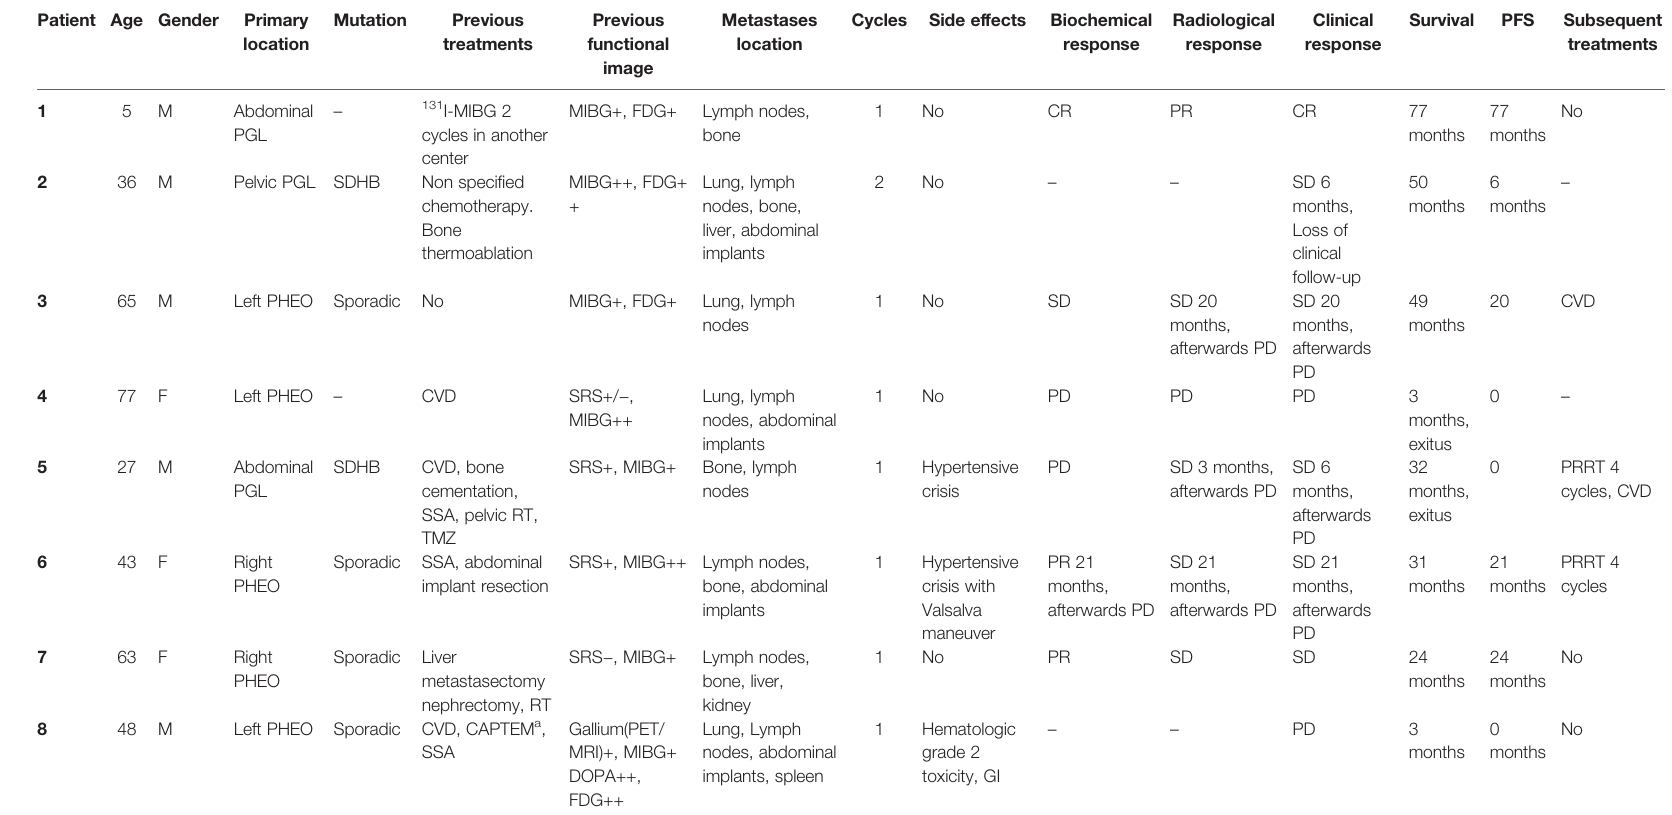
TABLE 3 | Patient characteristics in [ 131